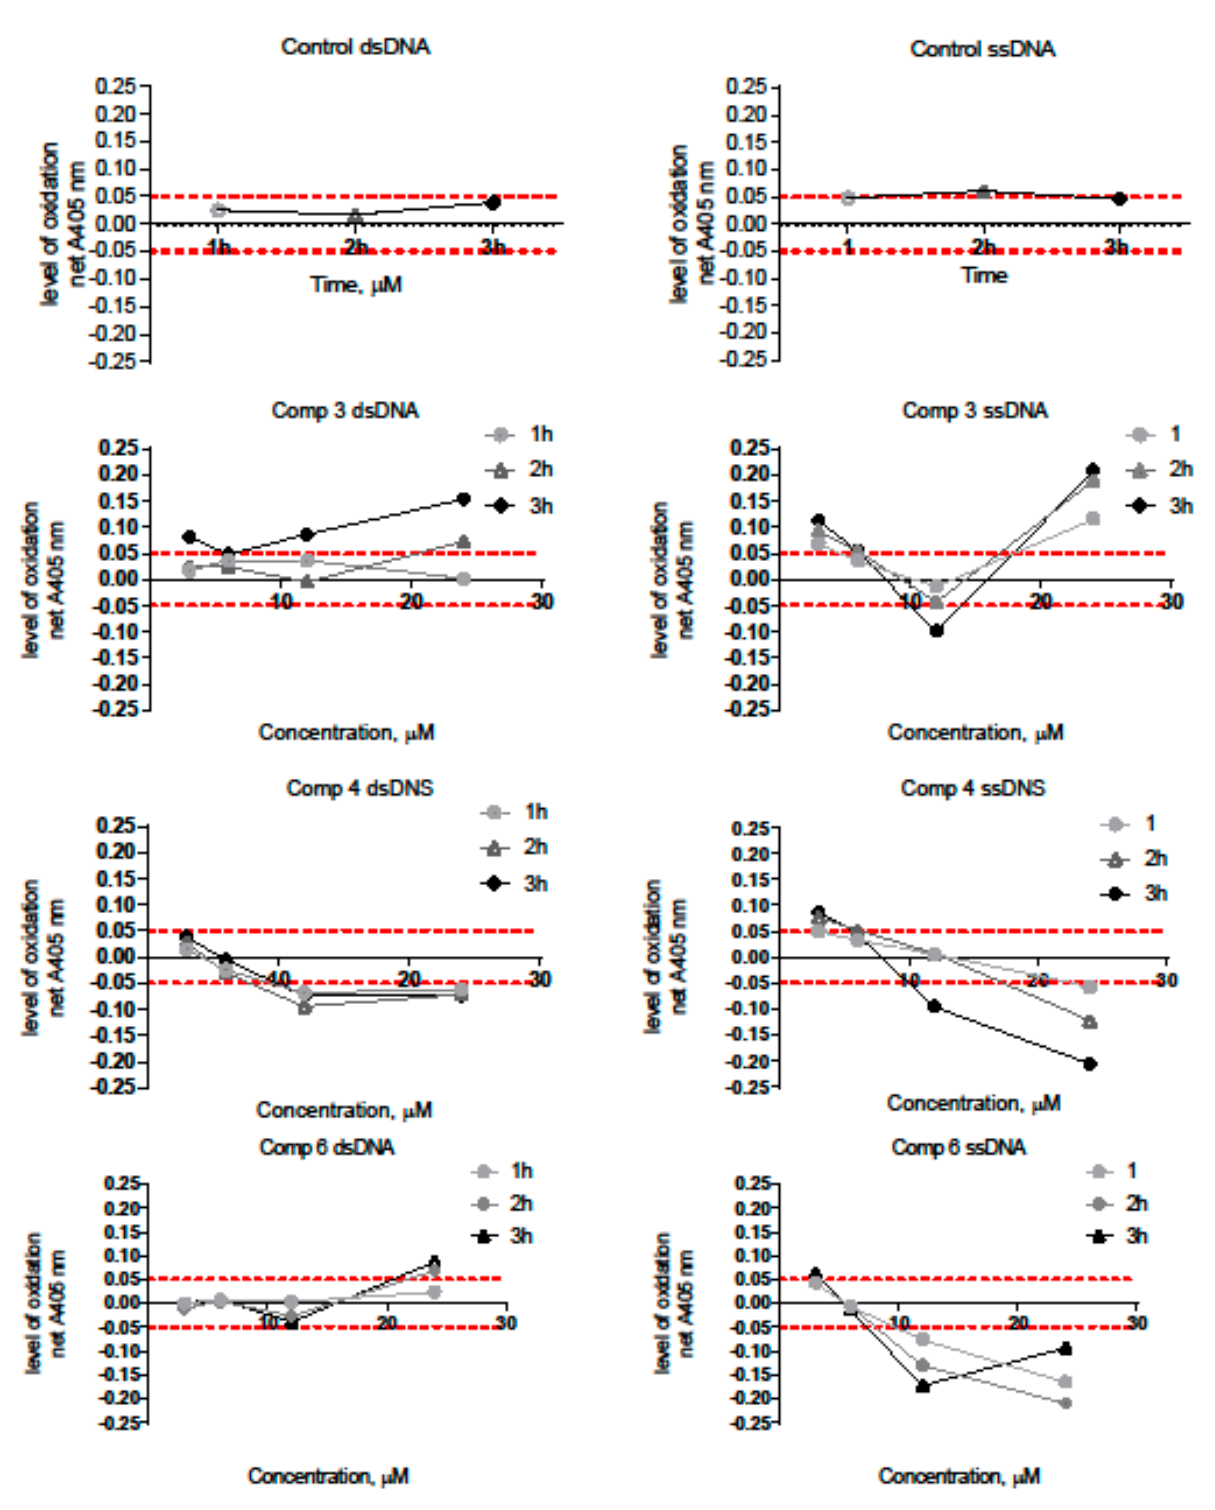
Figure 14. DNA damage induced by the compounds during various periods of incubation. DNA- binding compounds were defined as falling within the groups where the net change in absorbance between zero and various time points was >0.05 or < − 0.05 (red